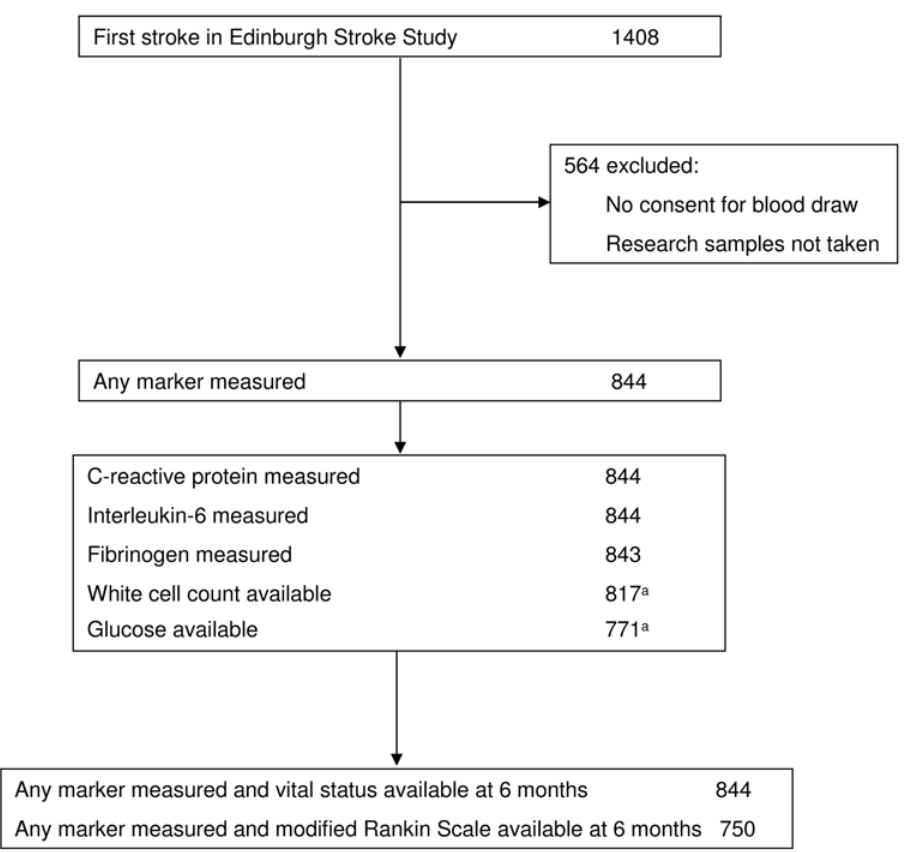
Figure 1. Flowchart of data available in the study. a Results are incomplete for glucose and white cell count, as for outpatients these results were sometimes reported to the general practice rather than the central results database.